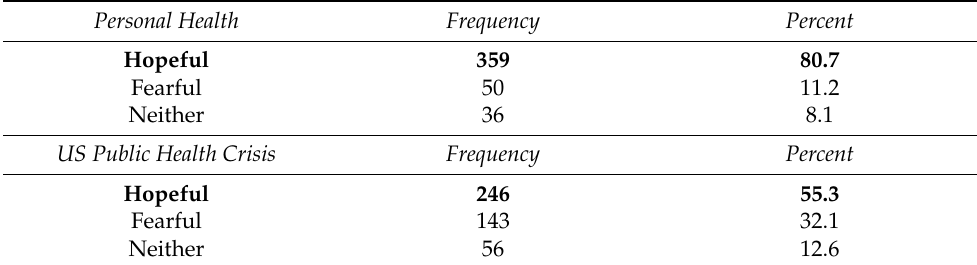
Table 2. Frequencies for Hopes and